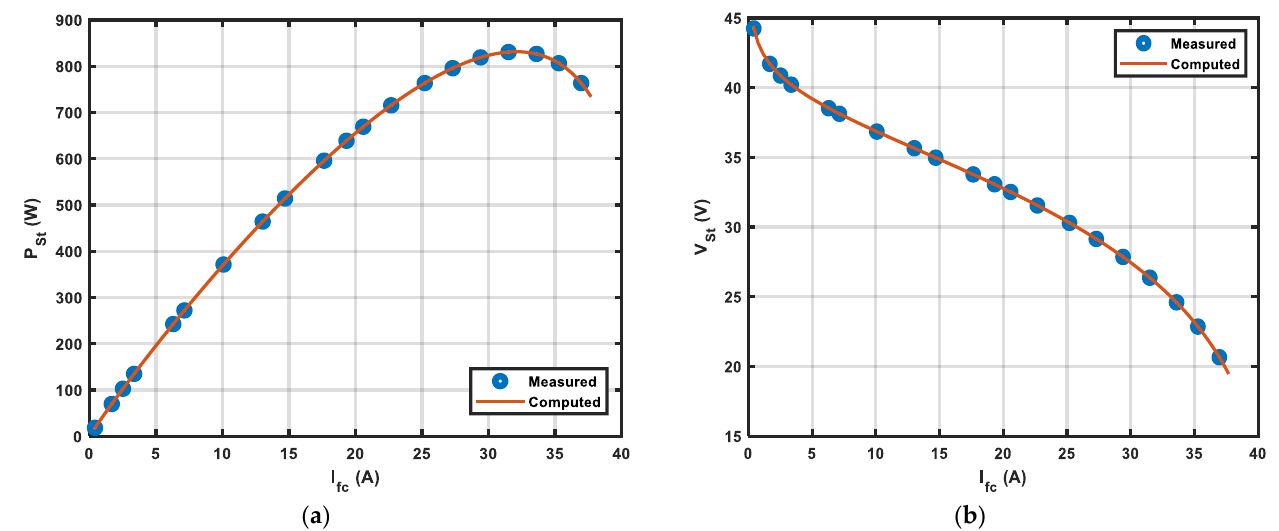
Figure 9. Depiction of I–V and I–P curves obtained using MGTO on test case 3: ( a ) I–P measured against I–P computed, ( b ) I–V measured against I–V computed. Table 7. Comparison among algorithms using test case 3.